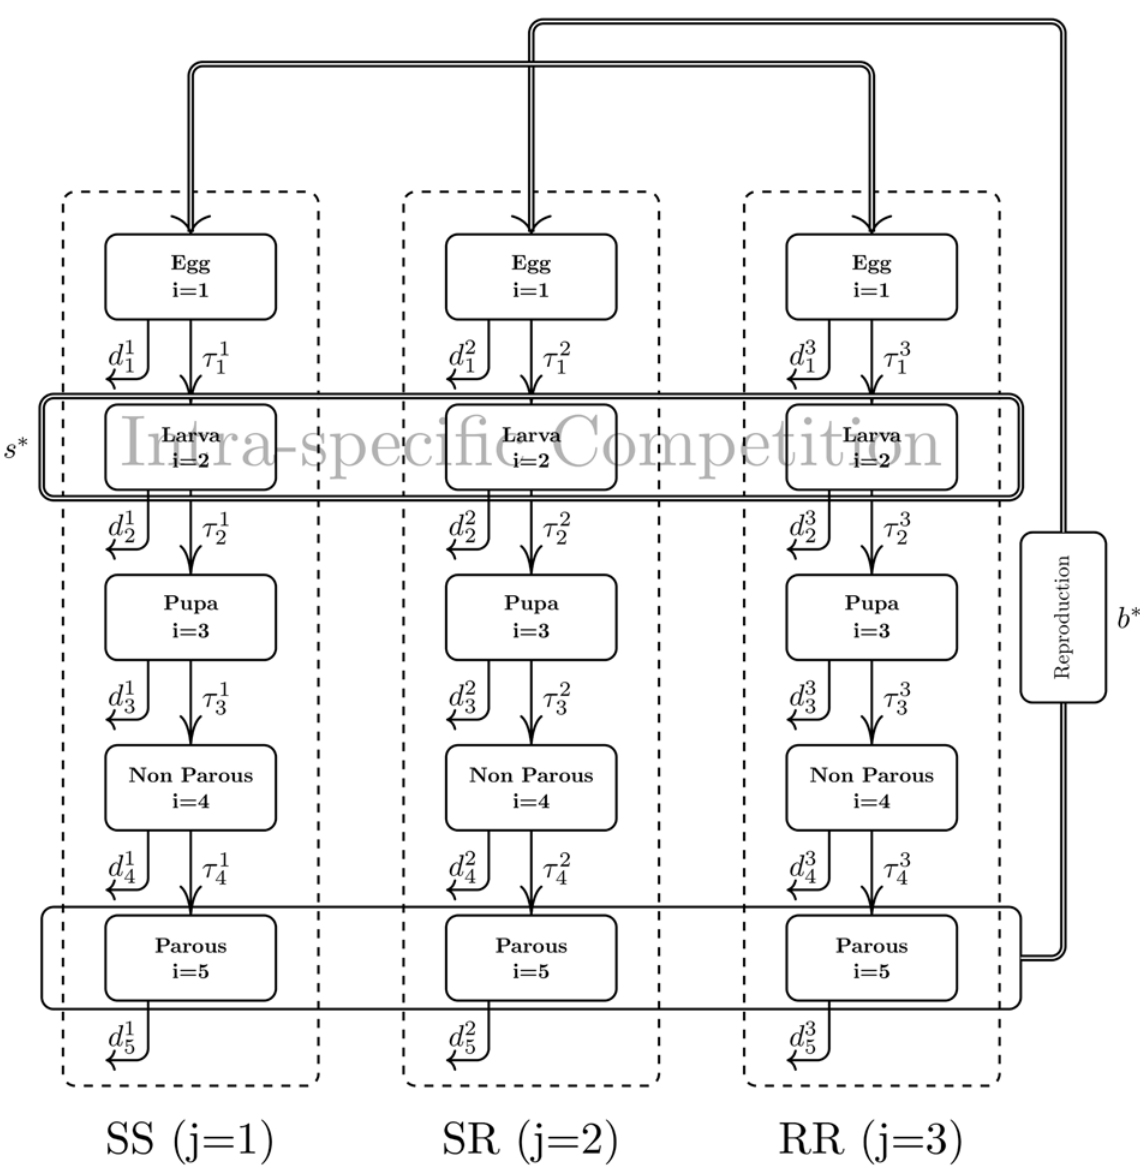
Fig 1. Compartmental model representation. The five life-stages of susceptible (SS), heterozygous (SR) and resistant (RR) mosquitoes are represented by rectangular boxes which are arranged in columns according to its genotype. Arrows connecting two boxes represents mosquitoes of a specific life stage maturing into another life stage, with the appropriate transition rate. Outward arrows represent removal of individuals from that specific life stage due to natural death. The thicker trifurcated arrow connecting the Parous stage to the Egg stage boxes represents an influx of eggs arising from random, non- preferential mating of parous winged mosquitoes. The Intra-specific Competition box represents a logistic type competition among larvae. Parameters are given in Table